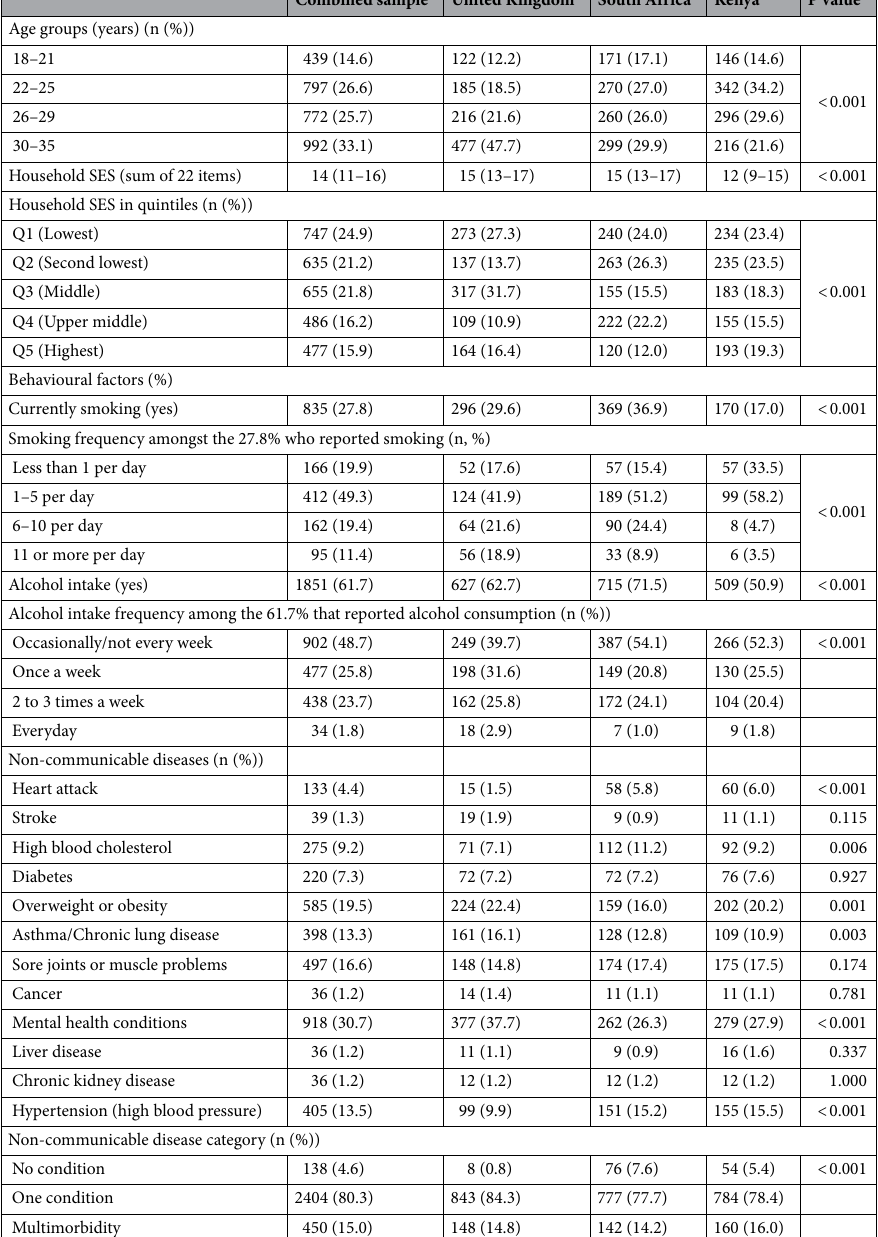
Table 1. Socio-demographic, behavioural, and non-communicable disease characteristics of young adults from United Kingdom, South Africa, and Kenya. Data are presented as frequencies (%) and median (interquartile